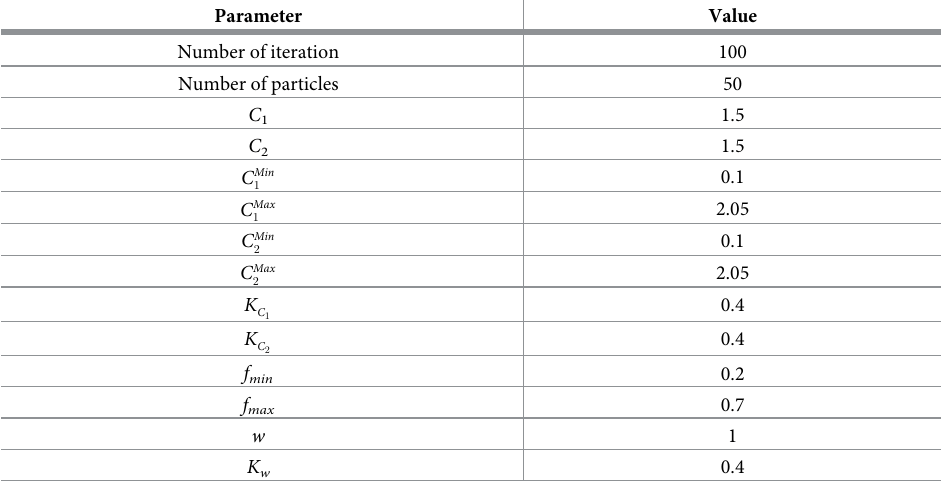
Table 1. Parameter for MOEPSO